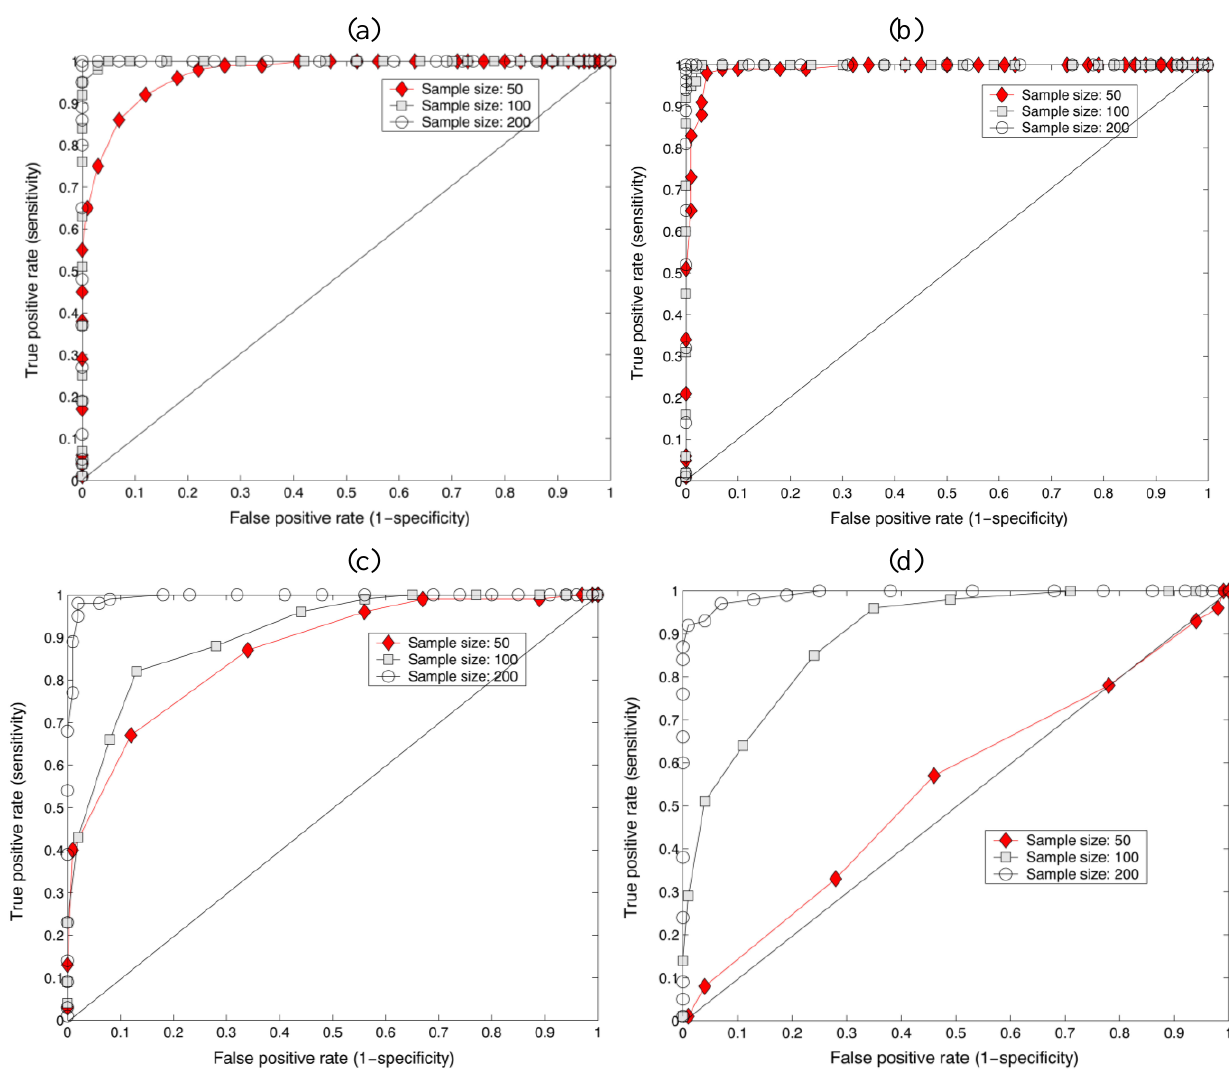
Figure 8. The ROC-curve results between reference and false class statistical distributions. The distributions are generated from the test statistic F-test and KS-test. Sampling segments are obtained from both real and imaginary parts in the reconstructed complex image. (a) ROC-curve result for real part in the complex image with F-test. (b) ROC-curve result for imaginary part in the complex image with F-test. (c) ROC-curve result for real part in the complex image with KS-test. (d) ROC-curve result for imaginary part in the complex image with KS-test. Reference: Oscillatoria bacteria. False class: Diatom